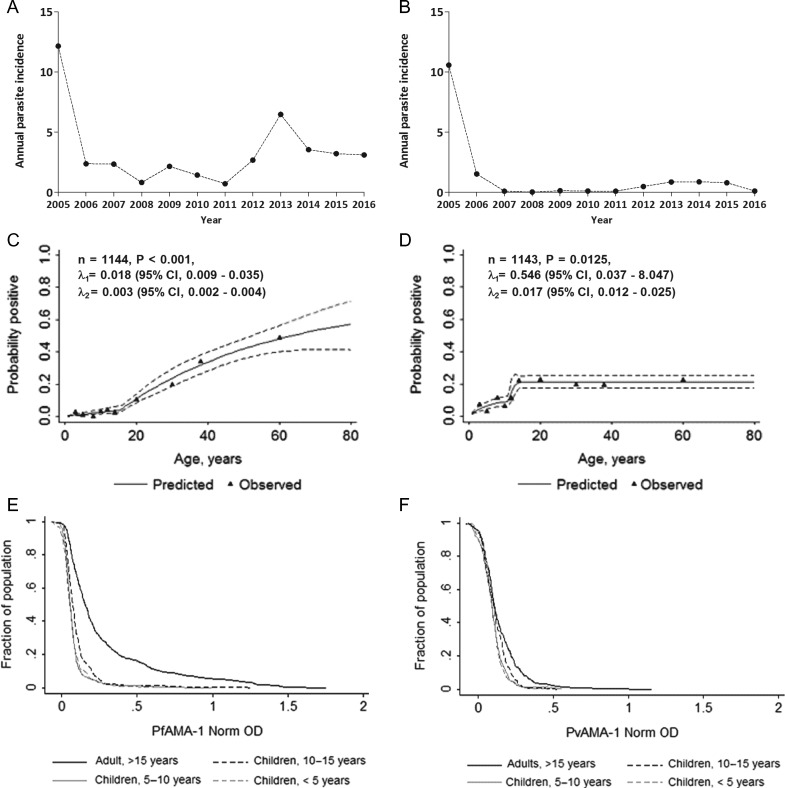
Annual parasite incidence, age seroprevalence plots and trends in antibody titres. Retrospective data from the district health bureau between 2005 and 2016 is presented for (A) P. falciparum and (B) P. vivax. Indicated on the y-axis is annual parasite incidence per 1000 population with the years indicated on the x-axis. Seroconversion curves are presented for (C) Pf-AMA (n=1144) and (D) Pv-AMA (n=1143) using a simple reversible catalytic model fitted by maximum likelihood. Triangles represent observed data and black lines represent predicted values. Dotted black lines represent upper and lower 95% CIs for the predicted seroprevalence by age. A likelihood ratio test was used to determine if a model with a change in transmission fitted the data best. Associated p-values as well as seroconversion rate estimates pre- and post-change are shown on the plots. Numbers indicate pre-change (λ1) and post-change (λ2) seroconversion values. Reverse cumulative distribution plots for age groups are indicated for (E) Pf-AMA and (F) Pv-AMA for the four age groups (adults >15 y of age, black lines; children 10–15 y of age, black dotted lines; children 5–10 y of age, grey lines; children <5 y of age, dotted grey lines). Shown in (E) and (F) are log10-transformed normalized OD values on the x-axis and the percentage of individuals having the indicated values or higher on the y-axis.